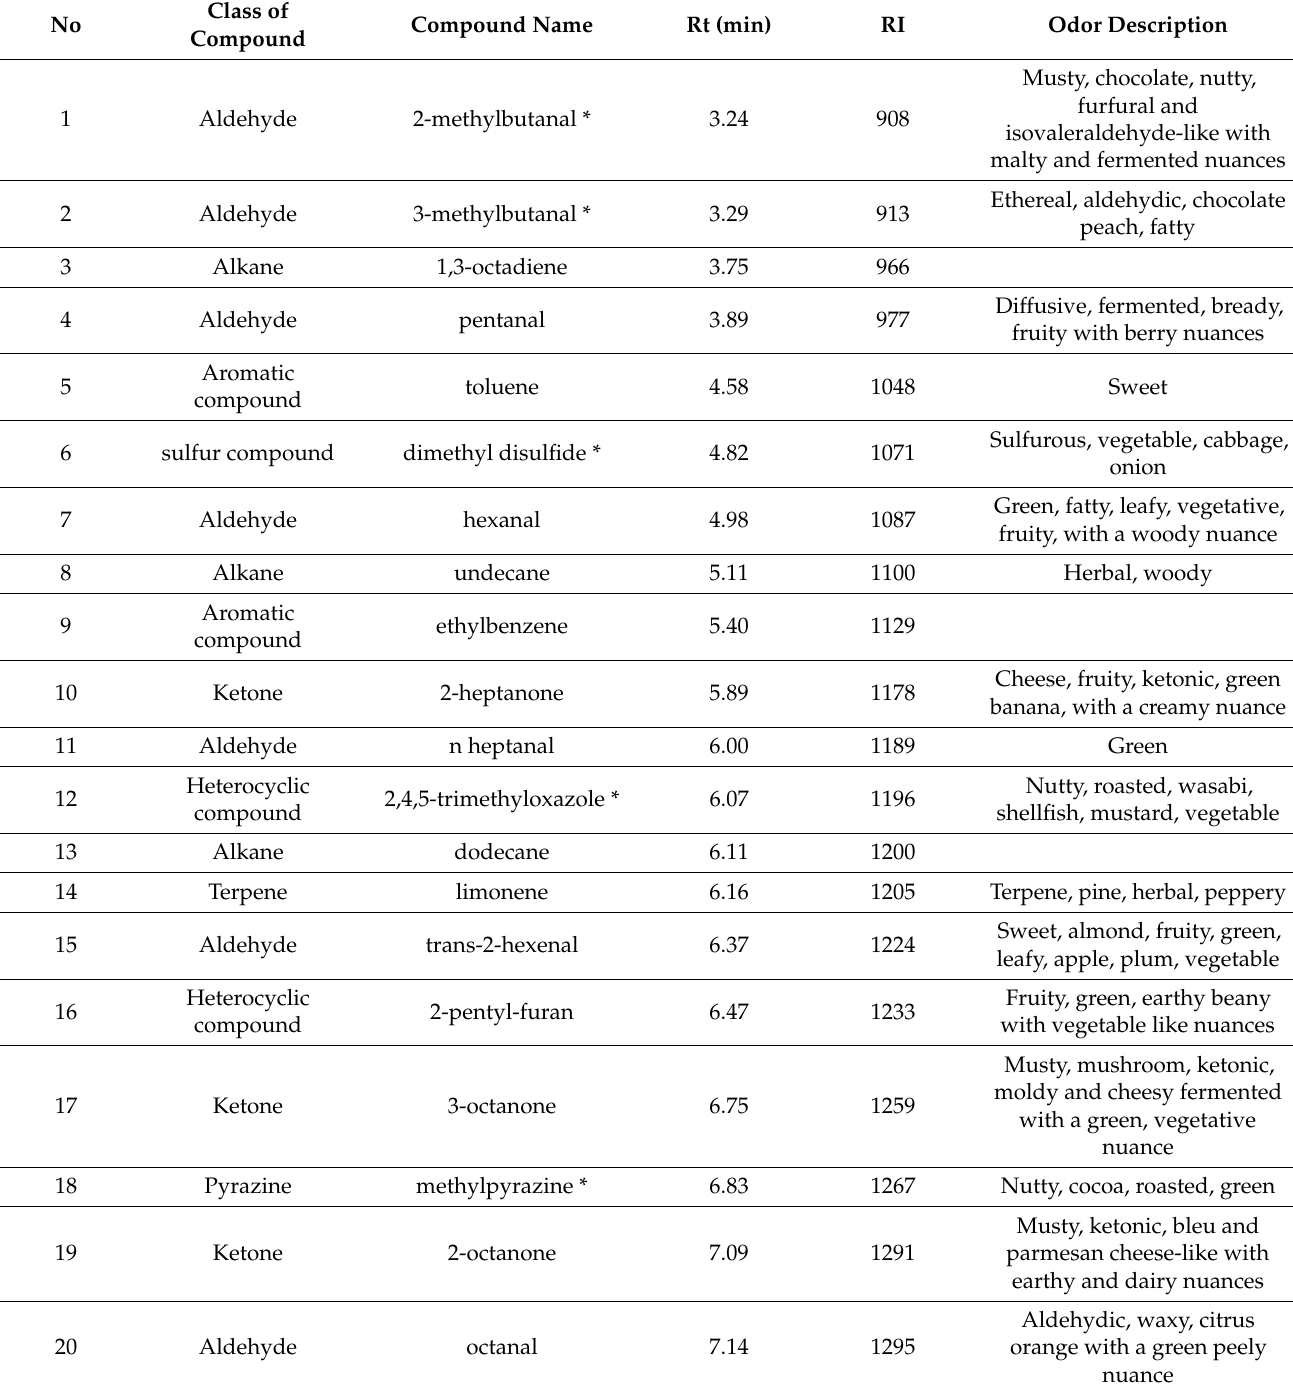
Table 1. Names, classes, retention times (Rt) and retention indices (RIs) of volatile compounds identified by gas chromatography–mass spectrometry